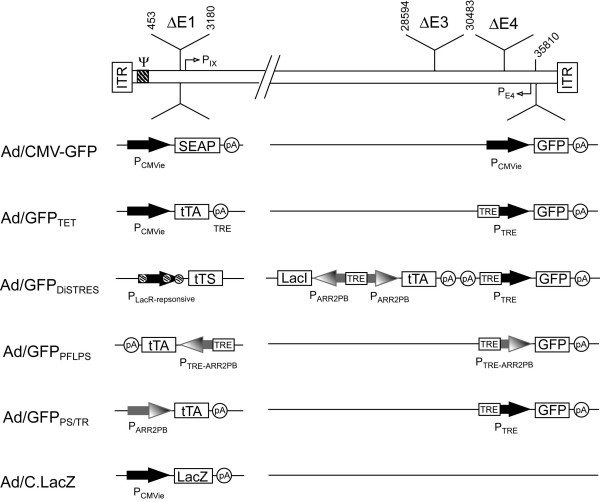
Structure of the Ad/GFPDiSTRES vector and controls. All transgene cassettes were first cloned into pLAd and pRAd shuttle vectors as described in the Methods section. Vector genomes were then assembled in vitro, as described previously [30, 31]. The resulting rAd vectors are E1-deleted and have a deletion in the E3 region (E3 promoter is retained). They also lack all of the E4 ORFs, except orf6, which is expressed from the E4 promoter.